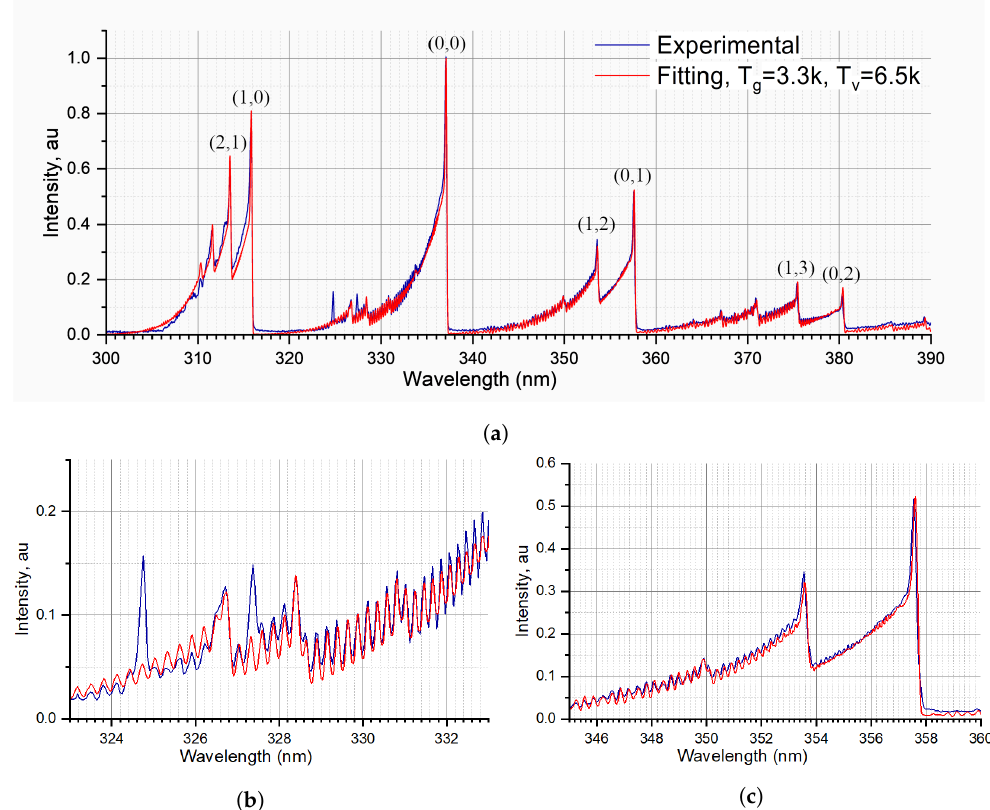
Figure 5. Fitting of experimental spectrum collected from plasma luminescence to the second positive system of nitrogen where ( a ) provides full wavelength range and ( b , c ) illustrate quality of fit in key wavelength